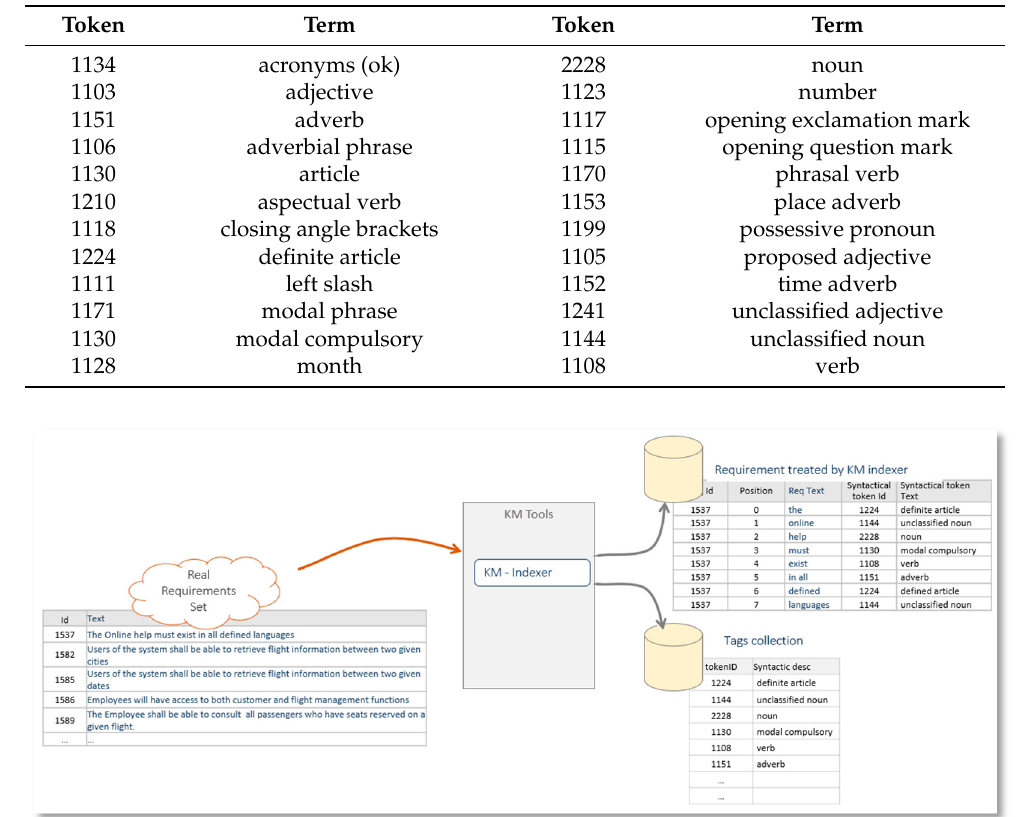
Figure 2. How KM Indexer process Requirements (tables, attributes, and relationships have been simplified to show relevant attributes for the experiment).